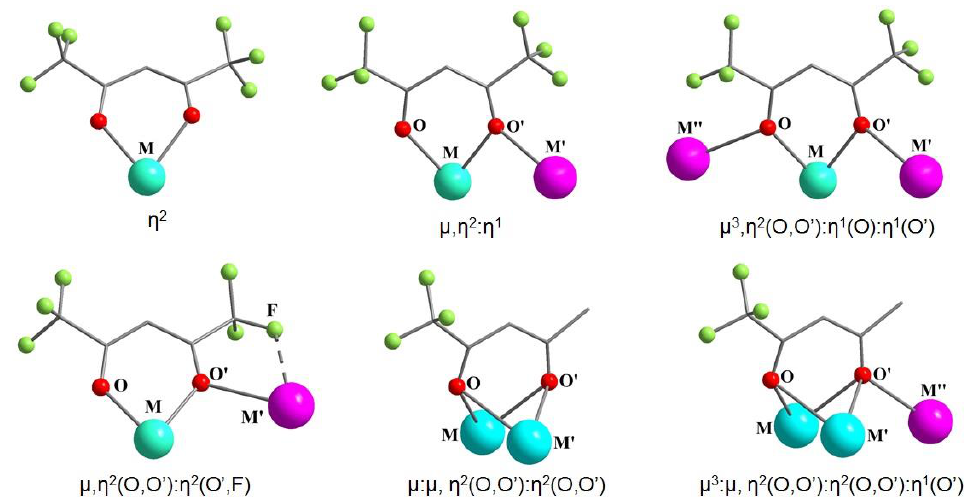
Figure 2. Possible coordination modes of fluorinated β -diketones.